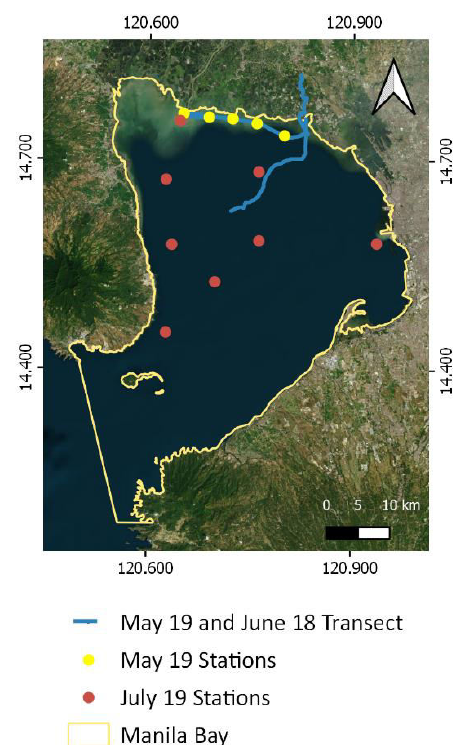
Figure 2. Water Quality Field Survey Points and Route